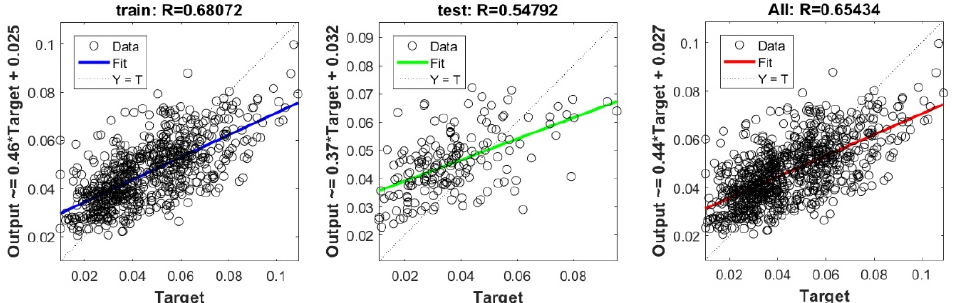
Figure A13. Scatter plots between target and output value by the GT-GP model.